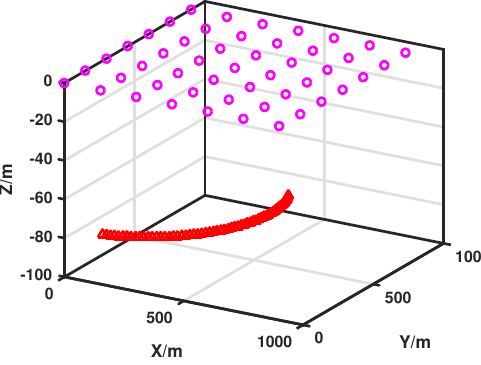
Figure 2. Simulation scenario (the purple circles stand for sensor nodes. They are deployed at water surface at first, the red triangle stands for moving target, and it moves in a plane